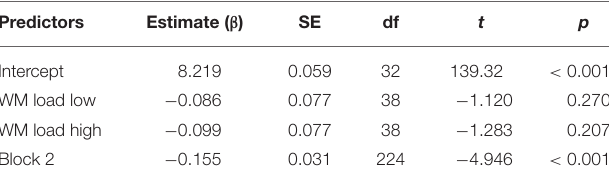
TABLE 5 | Overview of the model examining the influence of WM load on the pragmatic interpretation, with reference levels: WM Load: “No Load,” and Block: 1. Predictors Estimate ( β